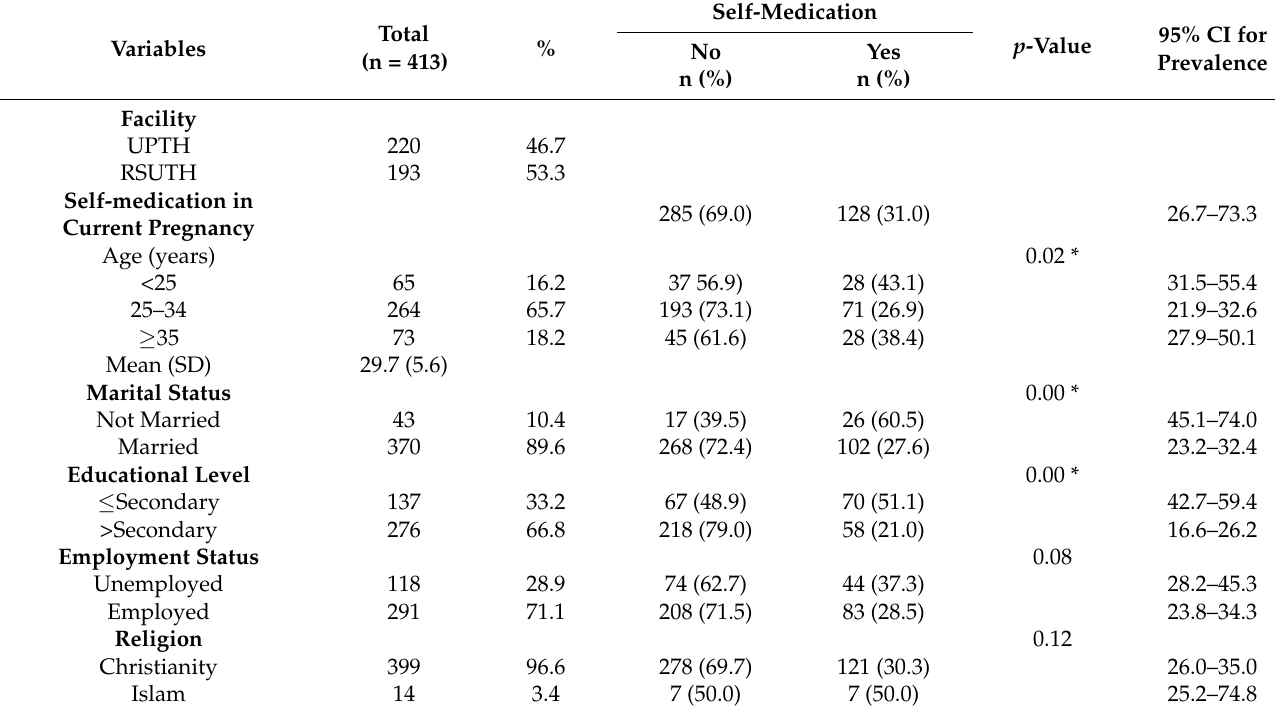
Table 1. Characteristics and prevalence of self-medication among pregnant